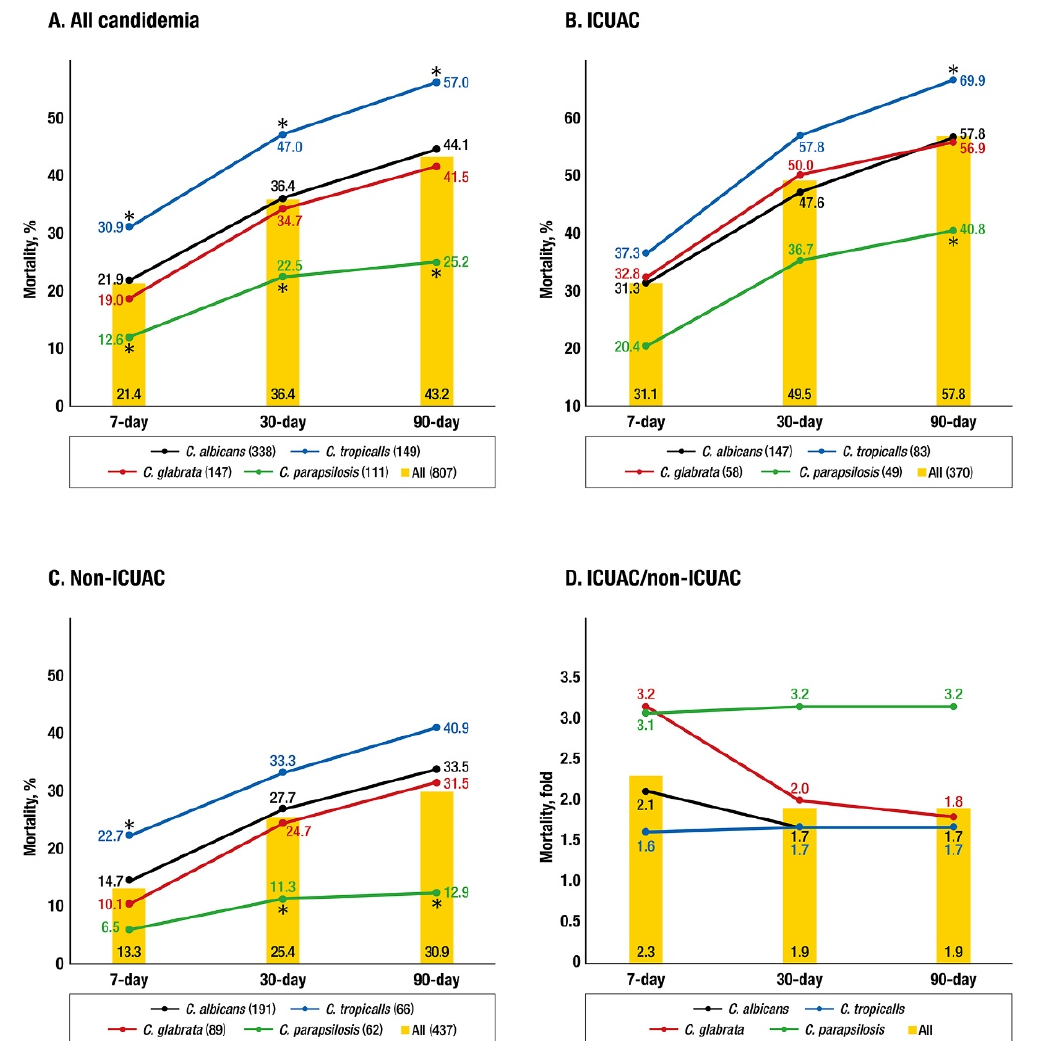
Figure 2. The cumulative 7-, 30-, and 90-day mortality rates in patients with all candidemia (338 C. albicans , 149 C. tropicalis , 147 C. glabrata , 111 C. parapsilosis , and 807 all) ( A ), intensive care unit-associated candidemia (ICUAC) (147 C. albicans , 83 C. tropicalis , 58 C. glabrata , 49 C. parapsilosis , and 370 all) ( B ), and non-ICUAC (191 C. albicans , 66 C. tropicalis , 89 C. glabrata , 62 C. parapsilosis , and 437 all) ( C ). Fold changes in the ICUAC mortality rates compared to the non-ICUAC mortality rates, stratified by four common Candida species and all candidemia ( D ). Mortality due to all candidemia within a given category is represented by yellow-colored bars. Asterisks indicate that the mortality rate in patients with candidemia due to a specific Candida species was significantly different to those in all other patients within a given category ( p < 0.05).